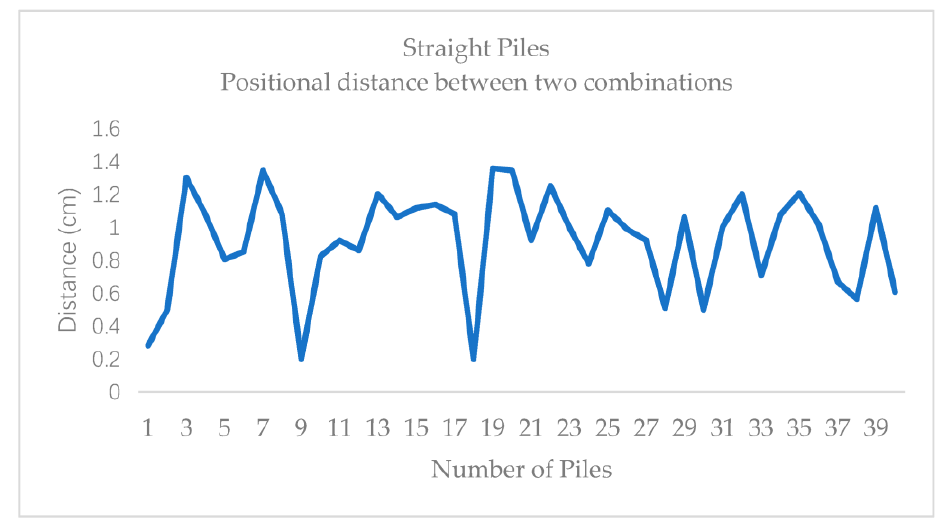
Figure 17. Positional difference between two combinations for straight piles.